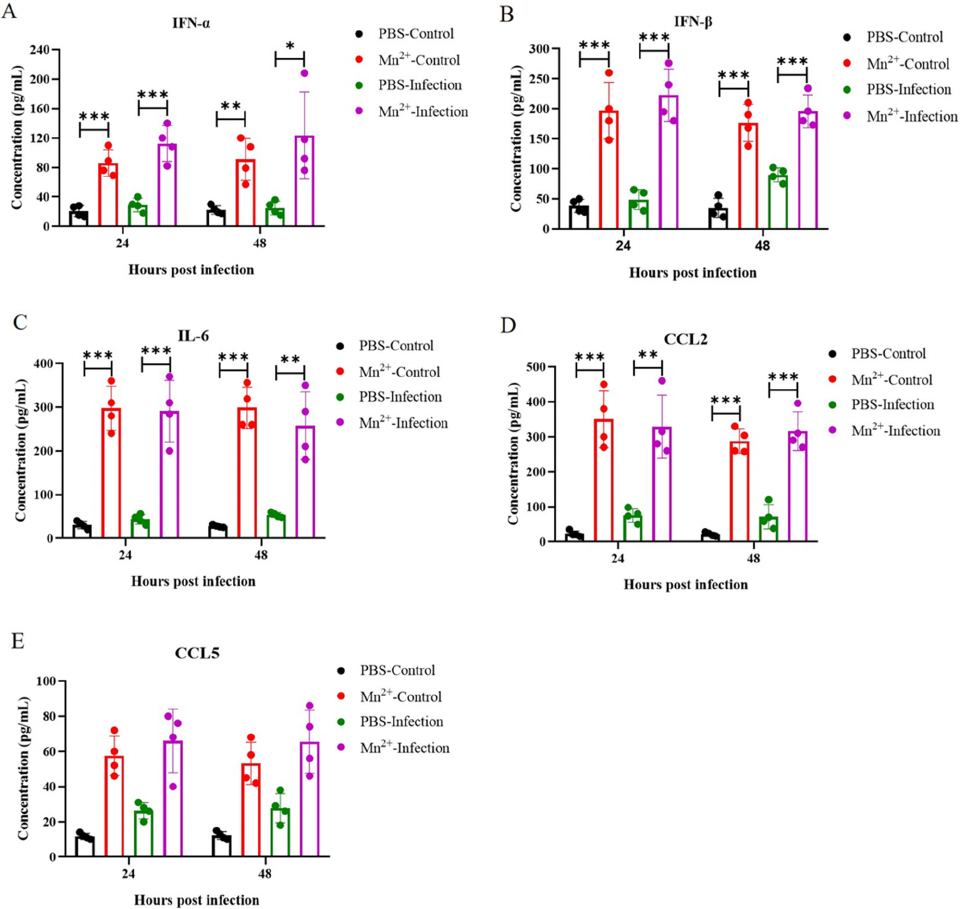
Figure 5. Induction of cytokines by Mn 2+ in mice. C57BL/6N mice were inoculated with 2 mg/kg Mn 2+ intravenously (I.V.) injection at 12 h before FMDV infection. Mice were challenged with 2 × 10 5 TCID 50 of FMDV by I.P. injection. Serum samples were collected at 24 and 48 h post-treatment and the protein levels of mouse IFN- α ( A ), IFN- β ( B ), IL-6 ( C ), CCL2 ( D ), and CCL5 ( E ) were measured using ELISA ( n = 4 per group). A t -test was performed to identify statistically significant differences. * p < 0.05; ** p < 0.01, *** p < 0.001.